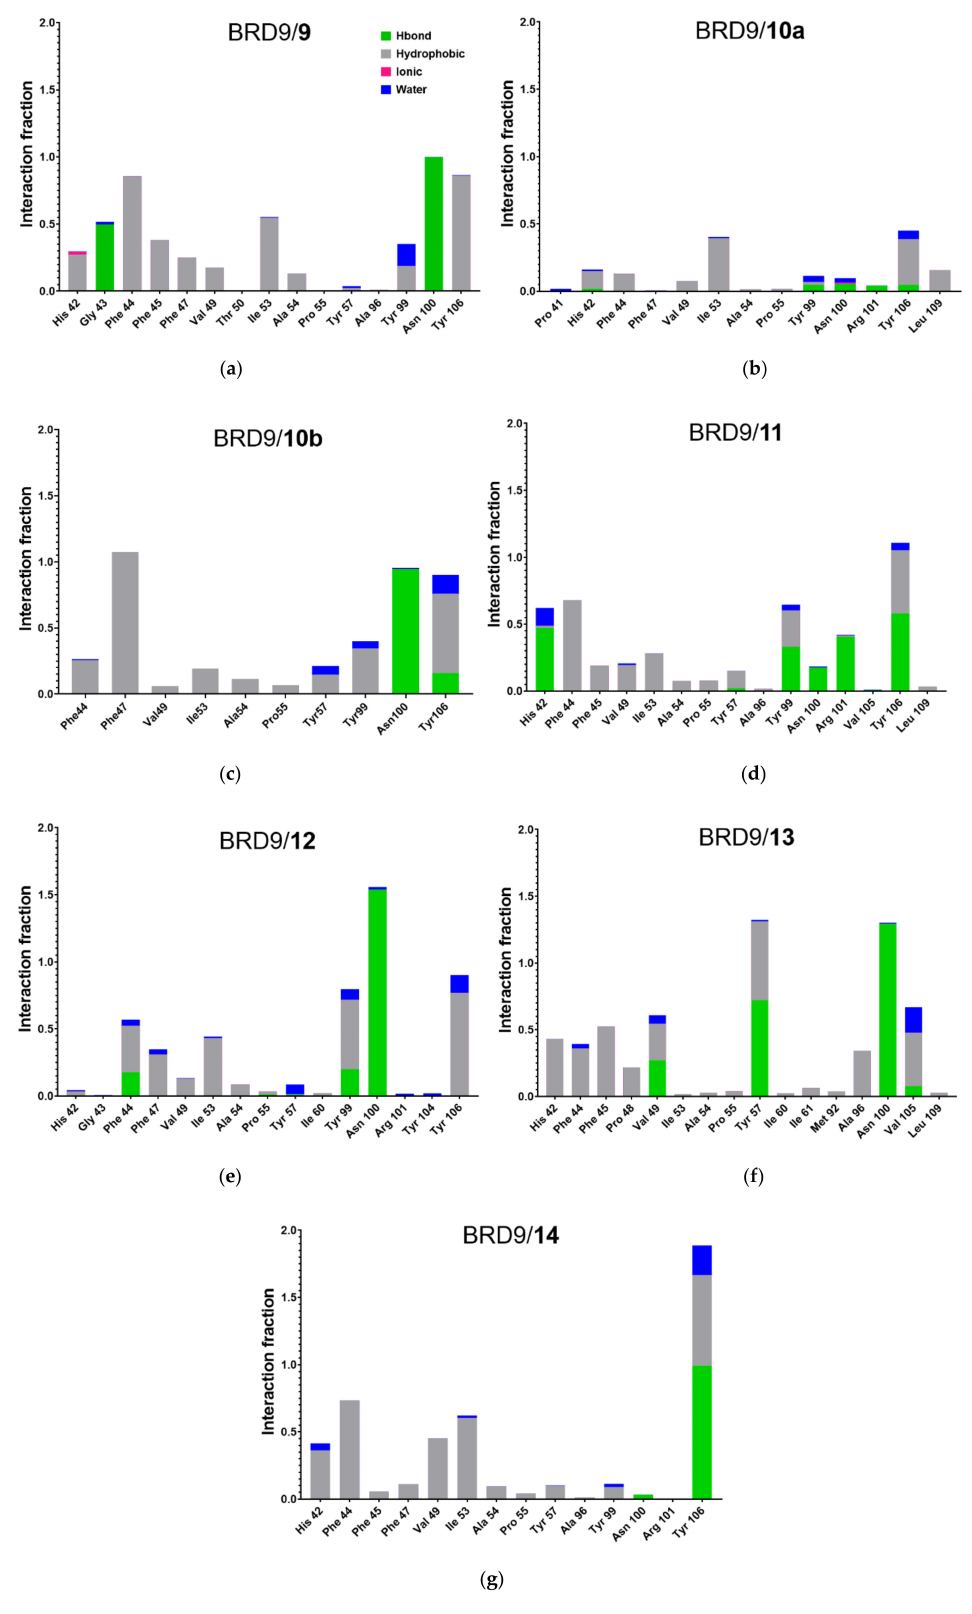
Figure 14. ( a – g ) Protein-ligand interaction histogram of the six complexes expressed as total time fraction. Values above 1.0 are the result of the cumulative effect of multiple interaction types or hydrogen bond donors/acceptors, specifically for ( a ) BRD9/ 9 , ( b ) BRD9/ 10a , ( c ) BRD9/ 10b , ( d ) BRD9/ 11 , ( e ) BRD9/ 12 , ( f ) BRD9/ 13 , ( g ) BRD9/ 14